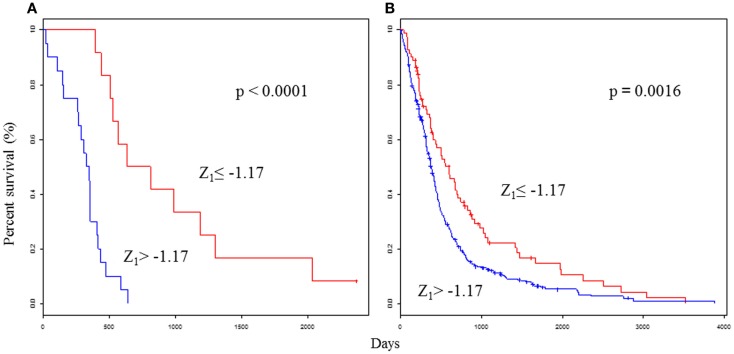
Survival analyses using the selected 25 gene classifiers show prognostic value for glioblastoma. Kaplan–Meier curves that compare groups classified by the Z1 PPS with the 25 gene model in the test set (A) and validation set (B). Permission for reuse was obtained from John Wiley & Sons Ltd. and ©2013 Japanese Cancer Association.